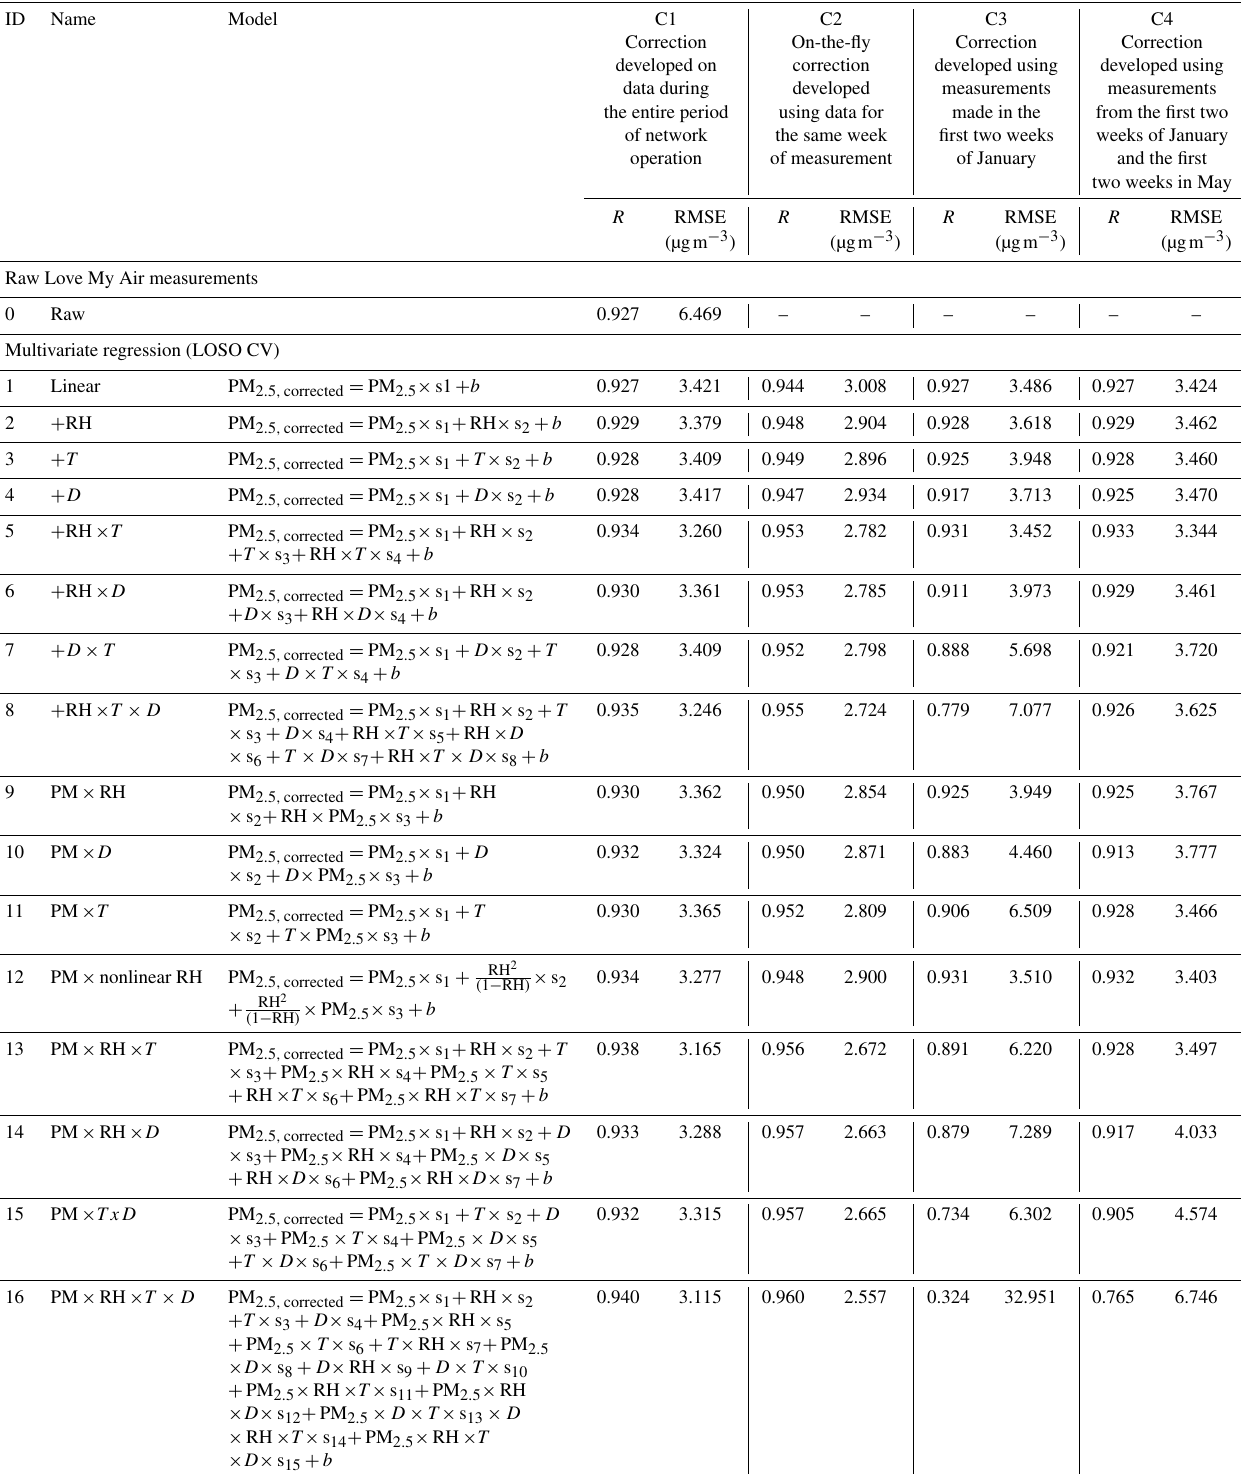
Table 2. Performance of the calibration models as captured using root mean square error (RMSE) and Pearson correlation ( R ). LOSO CV was used to prevent overfitting in the machine learning models. All corrected values were evaluated over the entire time period (1 January– 30 September